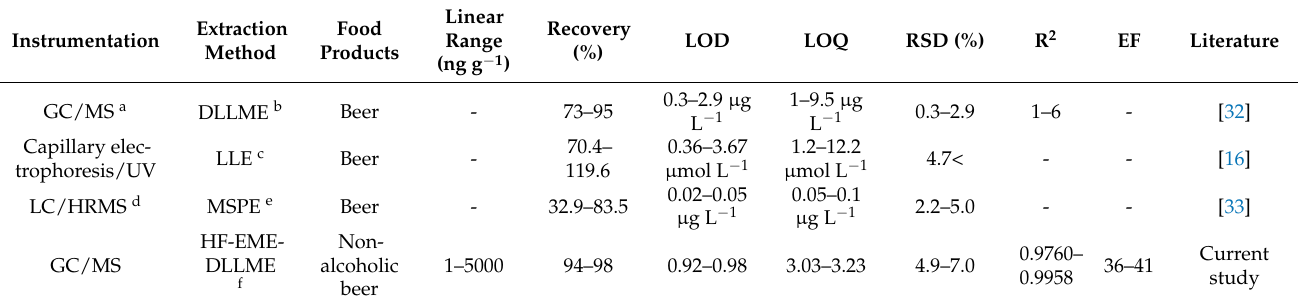
Table 2. Comparison of suggested method and previous procedures for BA extraction and quantifica- tion in beer